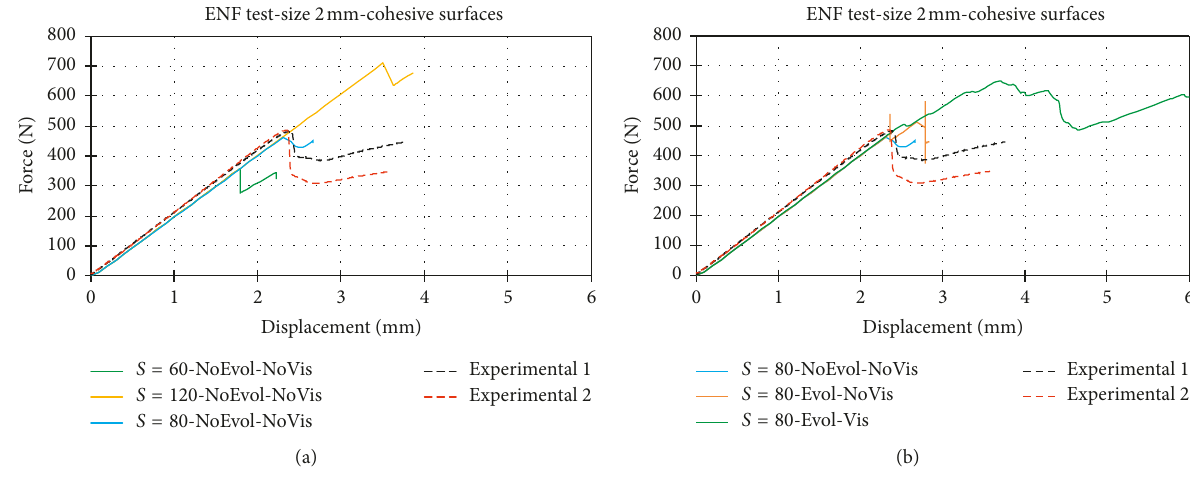
Figure 23: ENF test: cohesive surface approach (element size